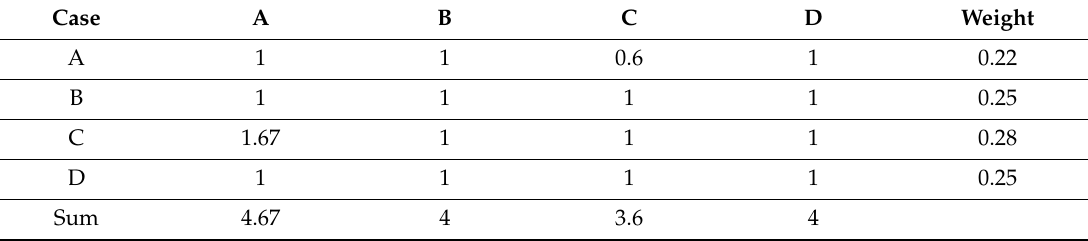
Table A3. Pairwise comparison of alternatives based on